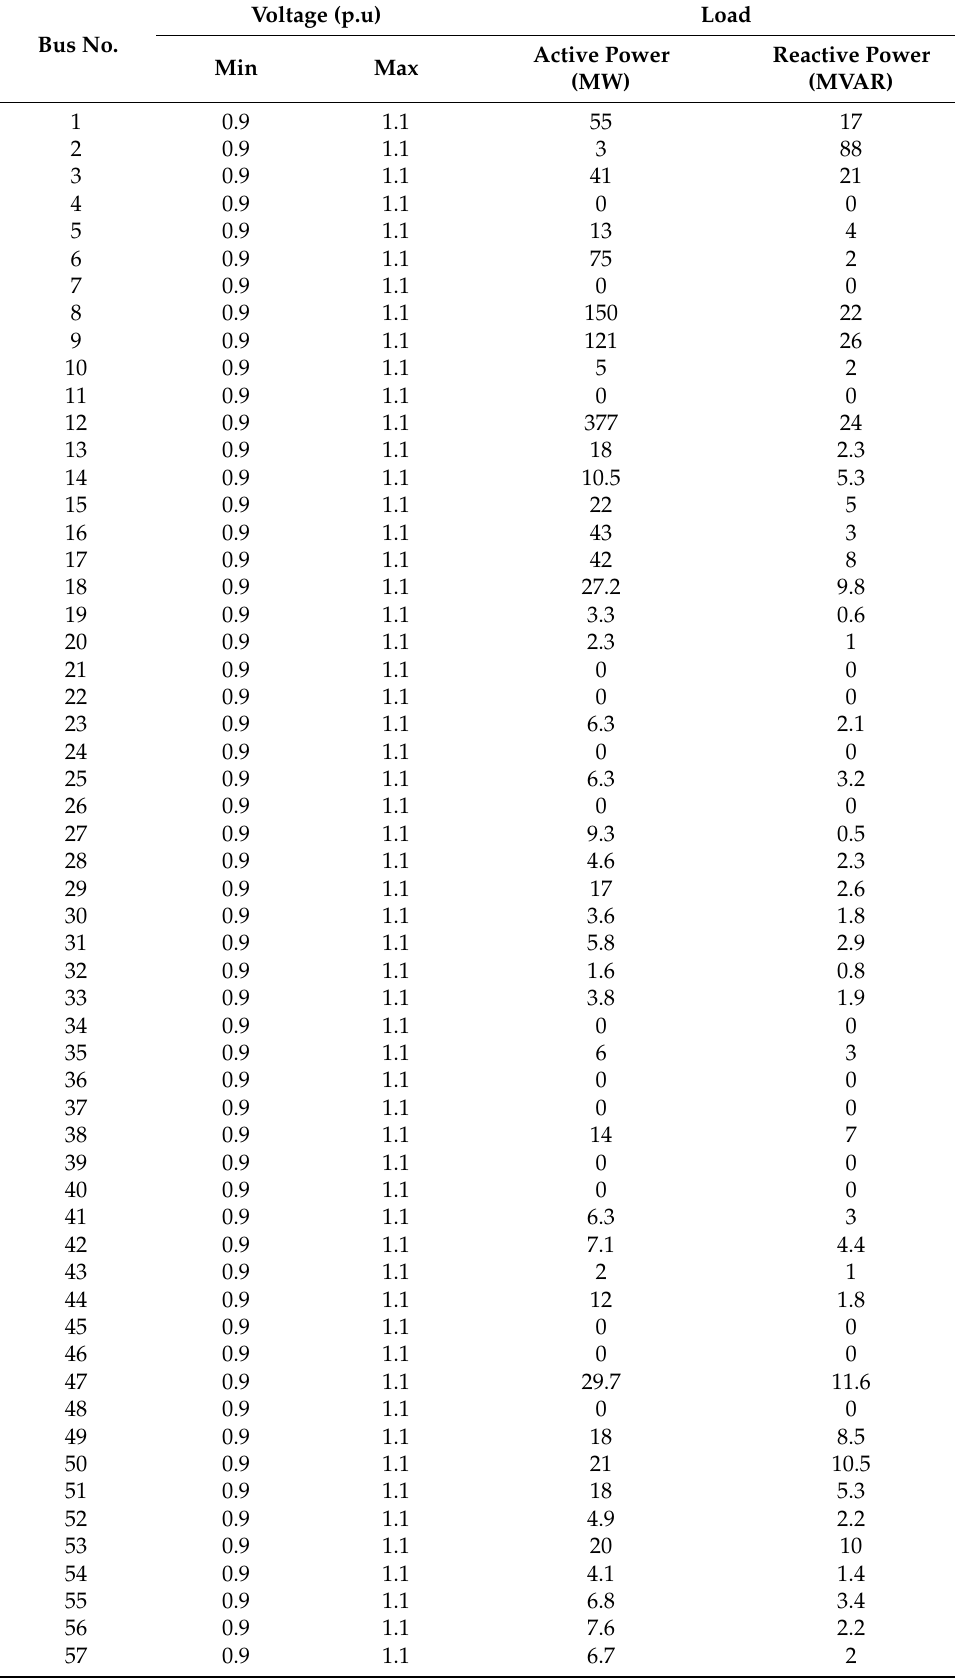
Table A1. Voltage constraints, and load data of each bus for the 57-bus system.